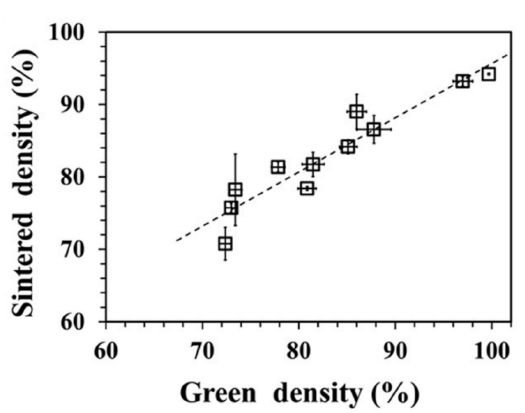
Figure 17. The green vs. sintered density of Ti-6Al-4V fabricated by metal MEX, demonstrating sintered density dependence on the green density (Reprinted with permission from [78]. Copyright 2021, Powder Technology, Elsevier).